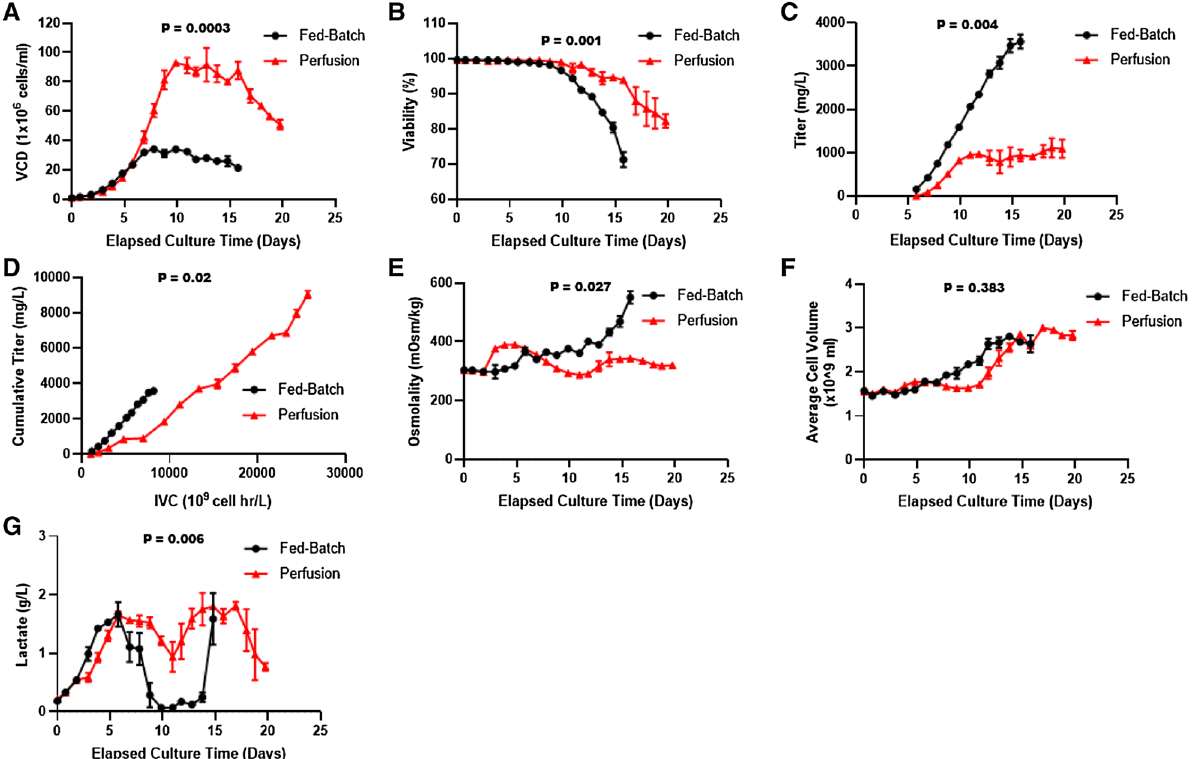
Figure 1. Comparison of process analysis between fed-batch and perfusion processes for BisAb production. Samples from each bioreactor were taken every day to measure ( A ) viable cell density, ( B ) cell viability, ( C ) day-day titer, ( D ) specific productivity, ( E ) osmolality, ( F ) cell volume and ( G ) lactate concentration. All data are expressed as mean ± SD from duplicate